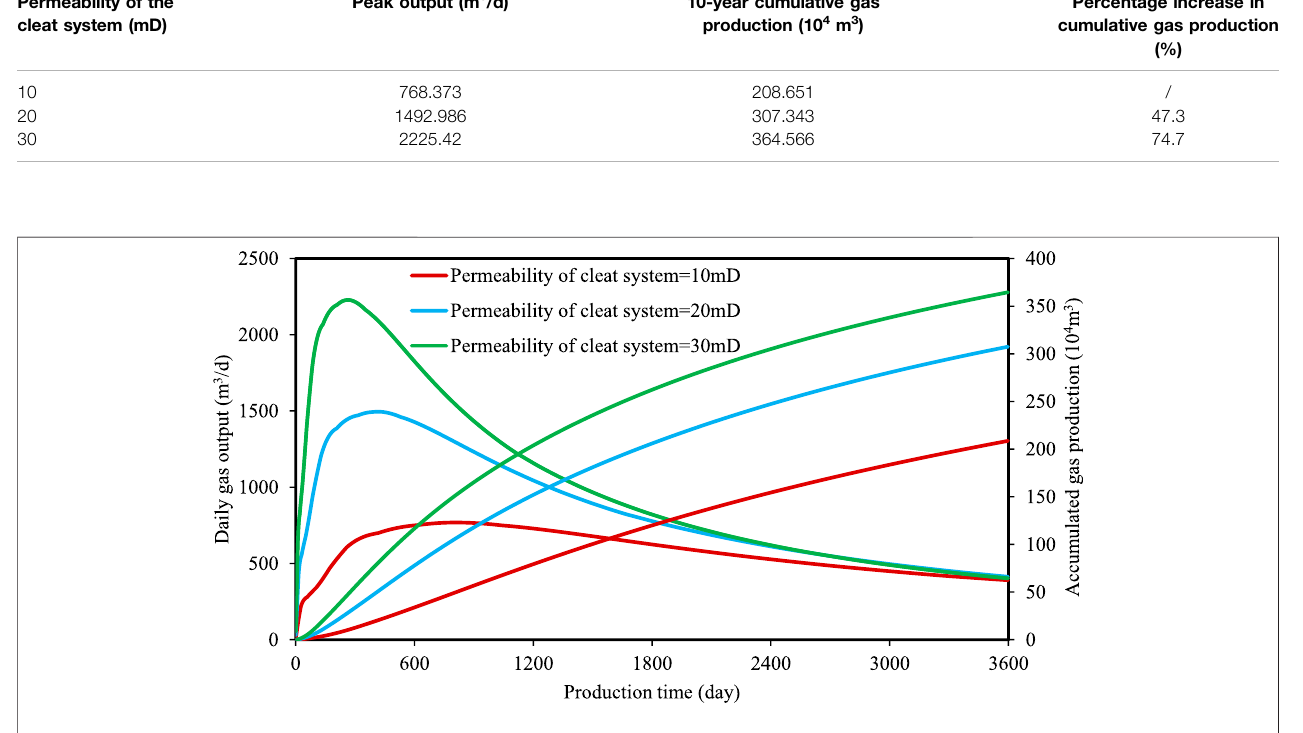
FIGURE 5 | Effect of permeability of coal seam cleat system on production.